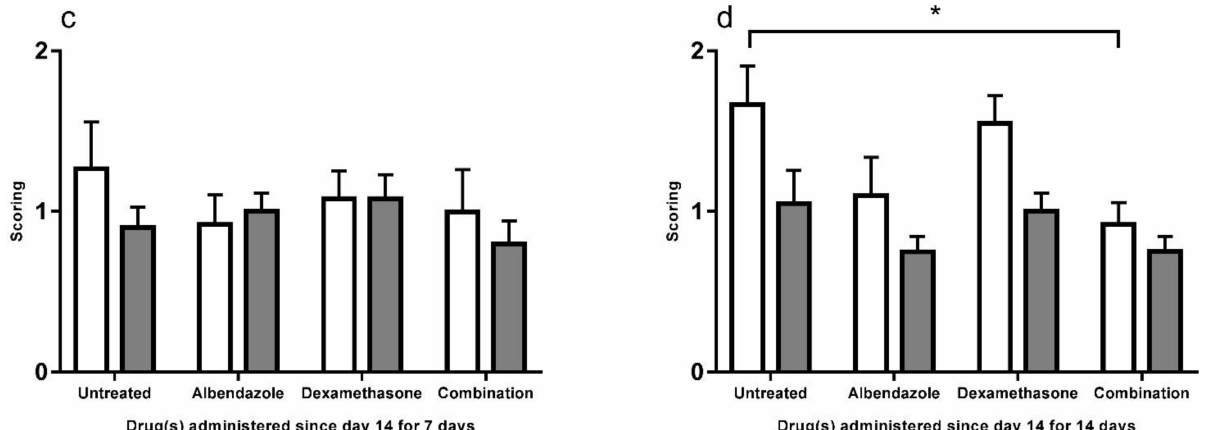
Figure 11. Scorings of size of larvae in the cerebral parenchyma of the BALB/c (white) and C57BL/6 (gray) untreated mice and those treated with albendazole alone dexamethasone alone, and co-therapy of the two drugs after infection with Angiostrongylus cantonensis . Data are expressed as mean ± standard error of the mean (Untreated group vs. albendazole group vs. dexamethasone group vs. co-therapy group, * p < 0.05) (BALB/c mice vs. C57BL/6 mice, # p < 0.05).